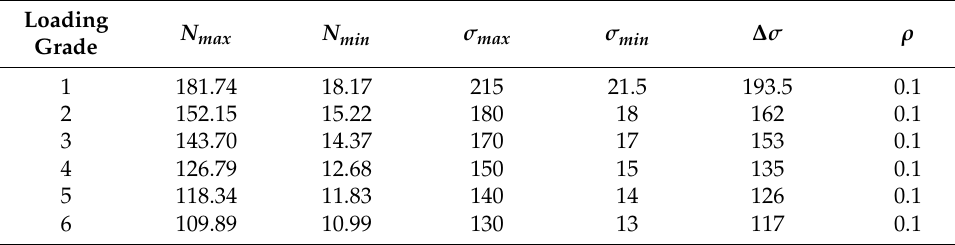
Table 4. Constant-amplitude fatigue test loading system of QP-76.